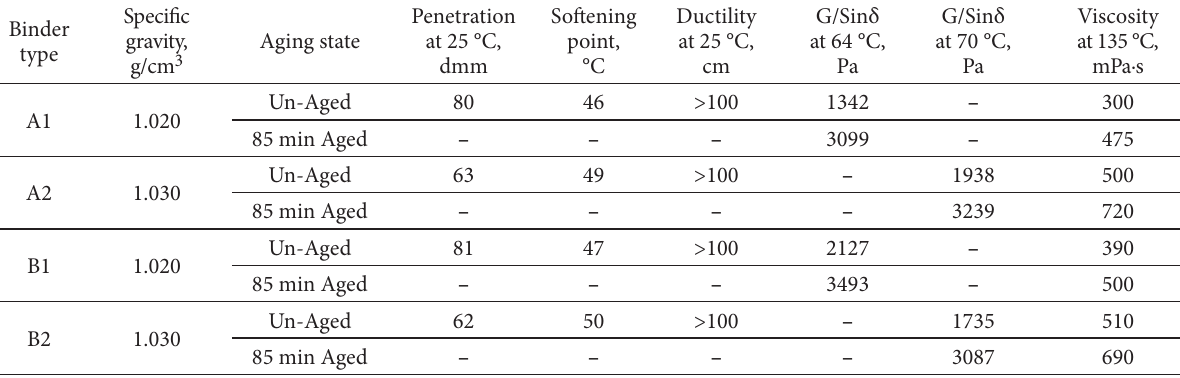
Table 1. Conventional binder properties Specific Binder type